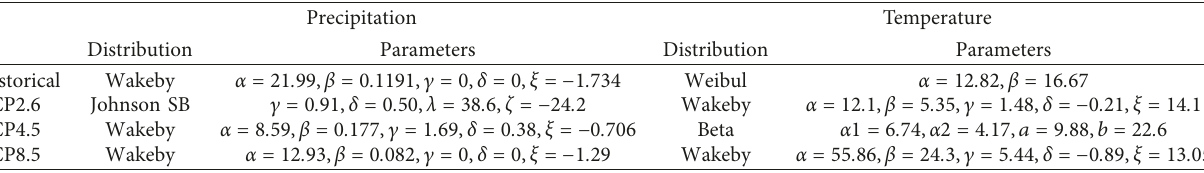
Table 8: Marginal distribution functions and selection of the best copula for joint modeling of temperature and precipitation in historical and future